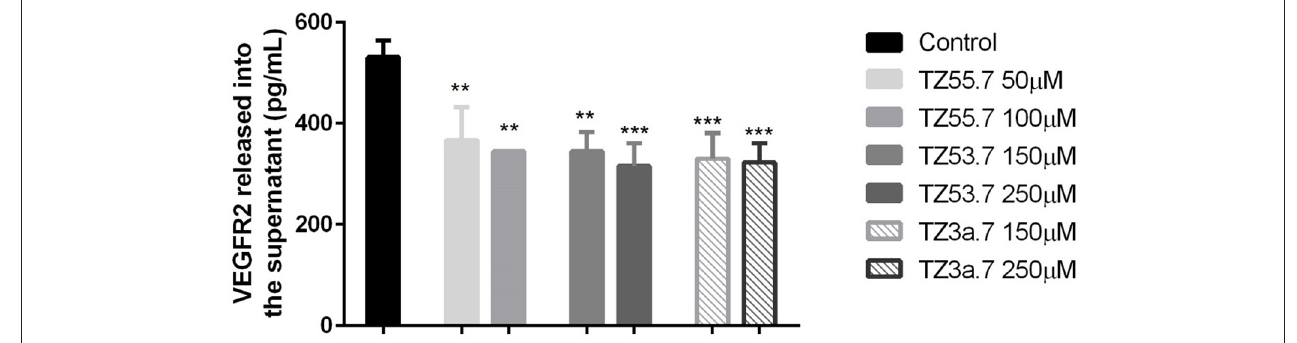
FIGURE 7 | ELISA determination of VEGF-R2 secreted by HT-29 cells into culture medium after stimulation with test compounds (TZ55.7 - 50 and 100 µ M, TZ53.7 - 150 and 250 µ M) and TZ3a.7 - 150 and 250 µ M) for 24h. The values are expressed as mean ± standard deviation. The statistical significance was determined with One-way ANOVA using GraphPad Prism 6 software (** p < 0.01, *** p <